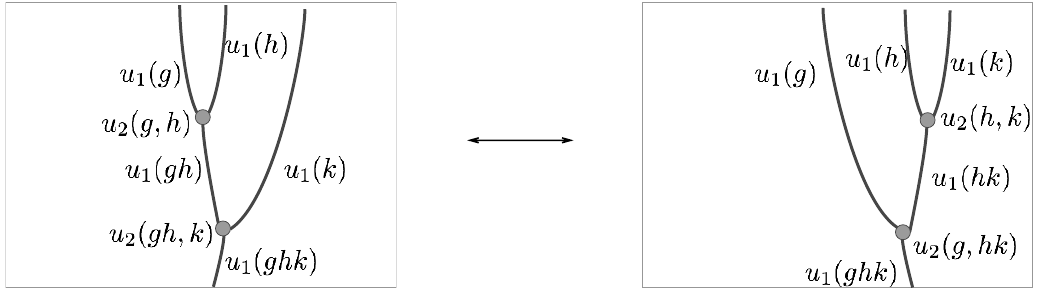
Figure 8 . Left: a localized (cid:13)at connection gives rise to invertible domain walls and junctions labelled by group elements. Domain walls in the trivial phase are identi(cid:12)ed with systems u 1 ( g ) in one dimension lower. Right: junctions between domain walls can be mapped to systems u 2 ( g; h ) in two dimensions lower at the cost of a non-canonical choice of reference junction (empty node) between the domain walls.